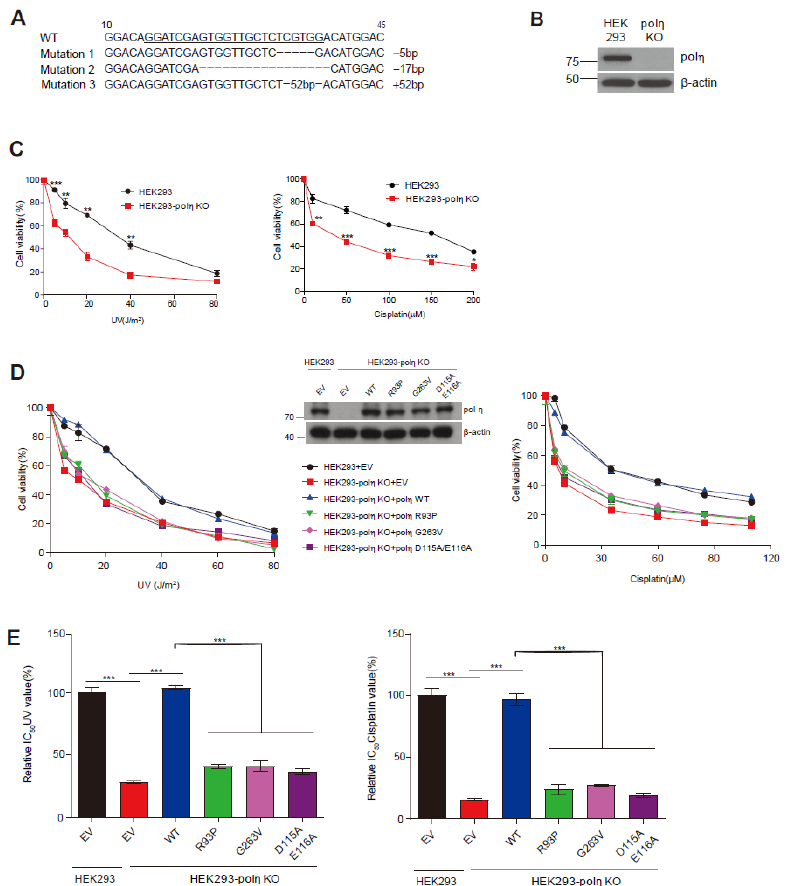
Figure 3. Complementation of UV and cisplatin sensitivity of POLH-knockout (KO) cells with wild-type pol η and D115A/E116A, R93P, and G263V mutants. ( A ) Genomic DNA sequences of the CRISPR/Cas9-mediated POLH-KO HEK293 cell line. The 20-bp target sequence is underlined. Three mutant alleles, which might be related to a near triploid karyotype of HEK 293 cells, with a 5-bp deletion, 17-base deletion, or 52-base addition, resulting in frameshifts at codon 11, 8, or 11, respectively, were verified by DNA sequencing of genomic PCR amplicons from POLH-KO cells. Numbers are relative to the transcription start site. ( B ) Immunoblots showing no pol η expression in POLH-KO cells. ( C ) Increased UV and cisplatin sensitivity of POLH-KO cells. Wild-type and POLH-KO cells were treated with UV radiation (0, 5, 10, 20, 40, or 80 J/m 2 ) or cisplatin (0, 10, 50, 100, 150, or 200 µ M), and cell viability was determined. Data are shown as means ± SEM from three independent experiments. * p < 0.05, ** p < 0.01, *** p < 0.001 vs. wild-type cells (Student’s t -test). ( D ) UV (left panel) and cisplatin (right panel) sensitivity of POLH-KO cells rescued only by wild-type pol η but not by three defective mutants. Wild-type and POLH-KO cells were treated with UV radiation (0, 5, 10, 20, 40, 60, or 80 J/m 2 ) or cisplatin (0, 10, 35, 60, 85, or 110 µ M), and cell viability was determined. Middle panel: Representative immunoblots of cell lysates (20 µ g) from wild-type and POLH-KO cells transfected with the indicated vectors. EV, empty vector. ( E ) Relative IC 50 UV (left panel) and IC 50 cisplatin (right panel) values for wild-type cells and POLH-KO cells expressing wild-type or mutants. IC 50 values calculated from Figure 3D were normalized to wild-type cells. Data are shown as mean ± SEM from three independent experiments. *** p < 0.001 (ANOVA with Tukey’s